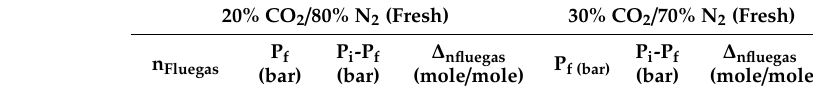
Table 8. Gas uptake calculations for 20% CO 2 / 80% N 2 and 30% CO 2 / 70% N 2 for fresh runs. Starting conditions are P i = 120 bar and T op = 1 ◦ C. GC analysis is carried out after a fresh run to measure the moles of CO 2 and N 2 left in the gas phase after hydrate formed. P eq for 20% CO 2 / 80% N 2 at 1 ◦ C is calculated as 56.85 bar for pure water using